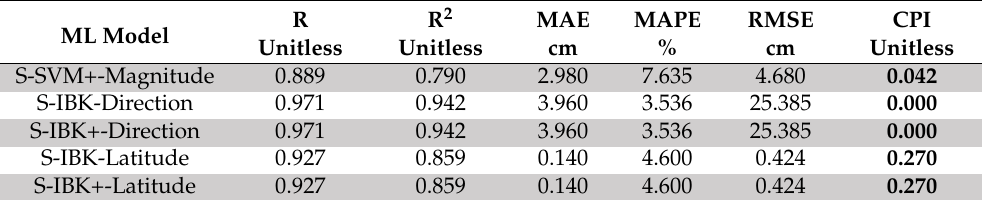
Table 2. Selected best prediction performance with boosted ML models on impact magnitude, direction and latitude, respectively. Five statistical parameters (i.e., R, R 2 , MAE, MAPE, and RMSE) and the composite performance index (CPI) are